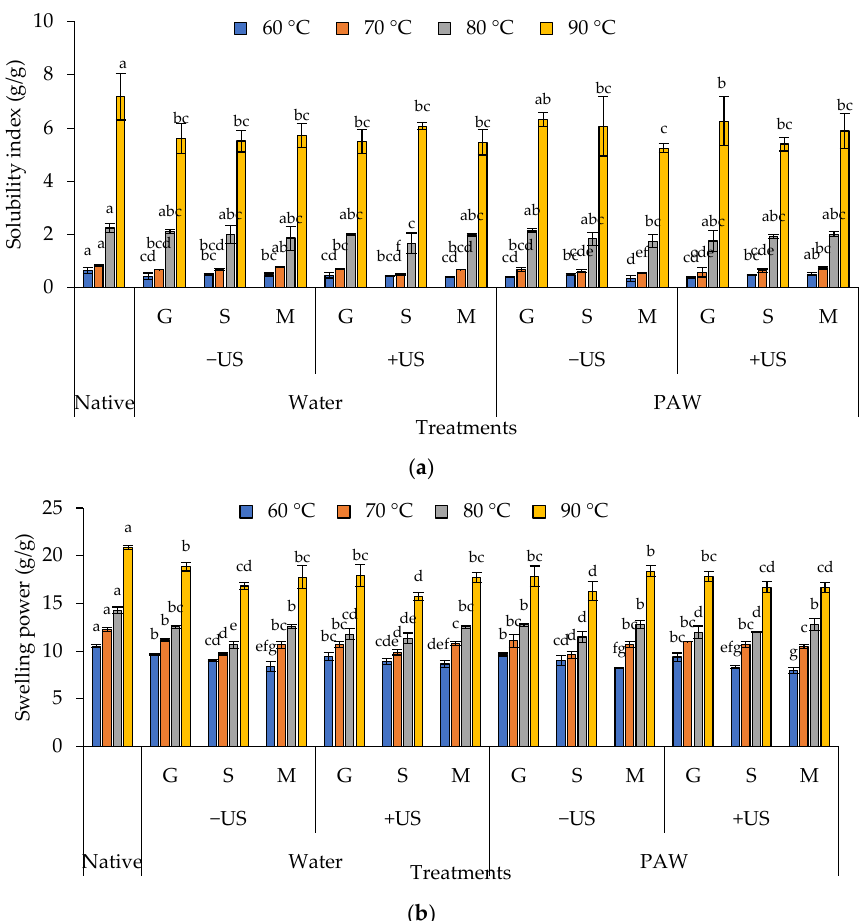
Figure 8. Water solubility index ( a ) and swelling power ( b ) of rice starch–phenolic complexes at different temperatures. Different phenolic compounds—gallic acid (G), sinapic acid (S), and crude